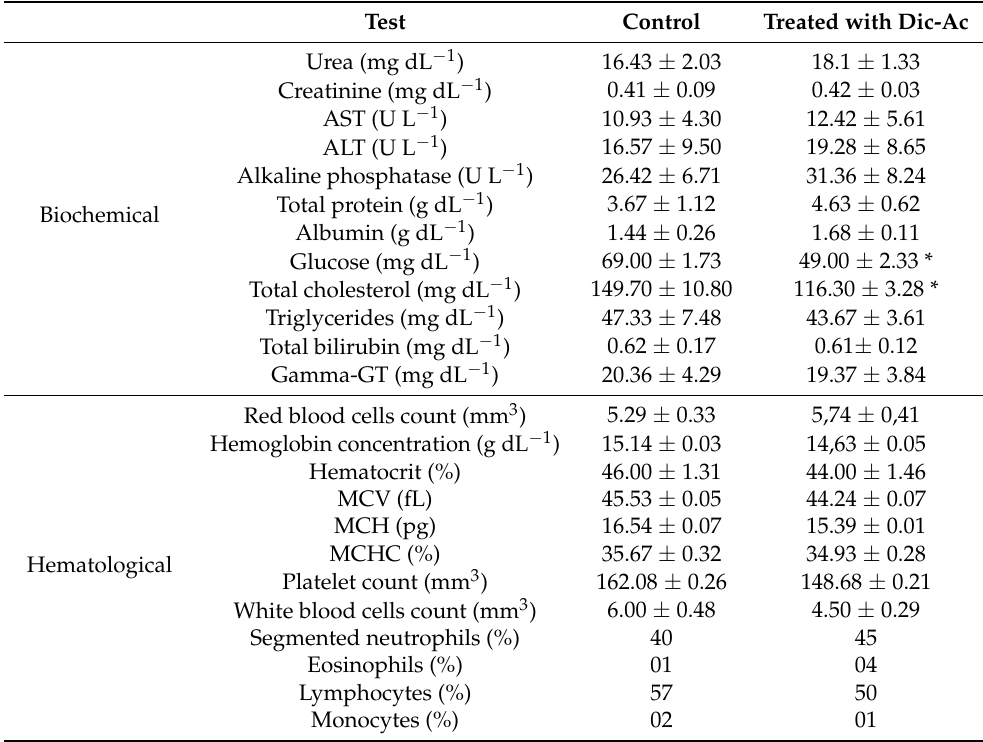
Table 4. Biochemical and hematological parameters of the control and treated groups with the Dic-Ac in the acute toxicity experiment (2000 mg kg − 1